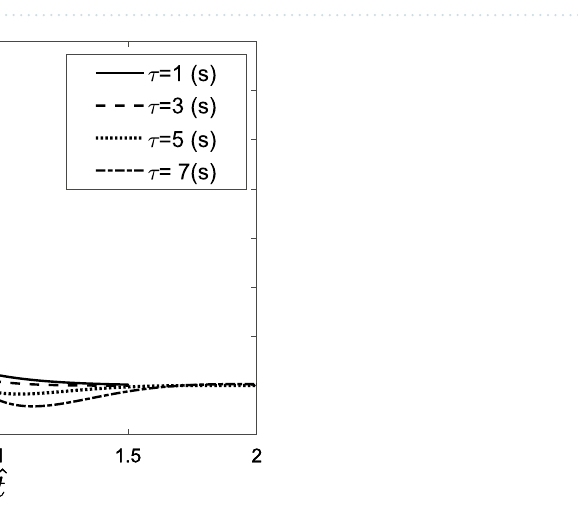
Figure 5. Temperature response of the skin tissue considering different relaxation time